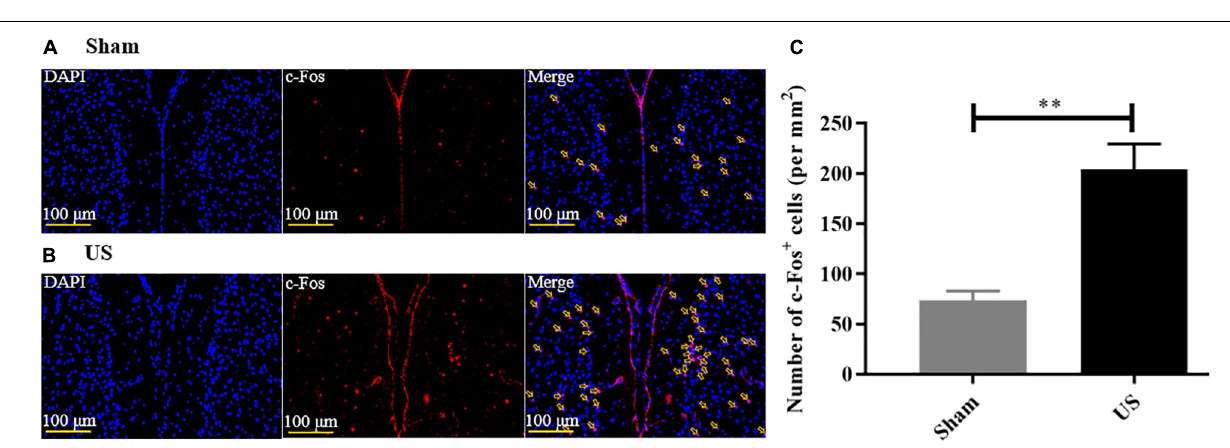
FIGURE 3 | US treatment increases the expression of c-Fos in the PFC of healthy mice. Representative images of c-Fos in the PFC after sham US (A) and US (B) for 30 min (nuclei: blue; c-Fos: red). (C) The amount of c-Fos protein in the US-treated group ( n = 6) is significantly greater than that in the sham group ( n = 4). US, ultrasound stimulation; PFC, prefrontal cortex; LPS, lipopolysaccharide. ** p <